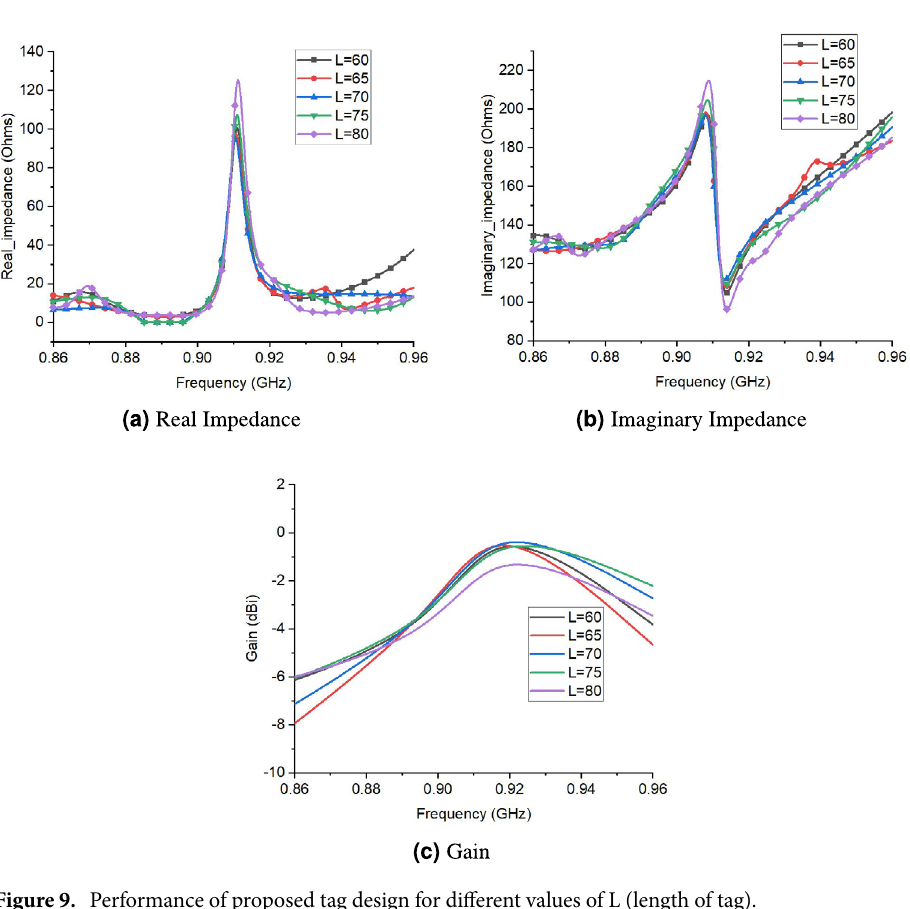
Figure 9. Performance of proposed tag design for different values of L (length of tag).